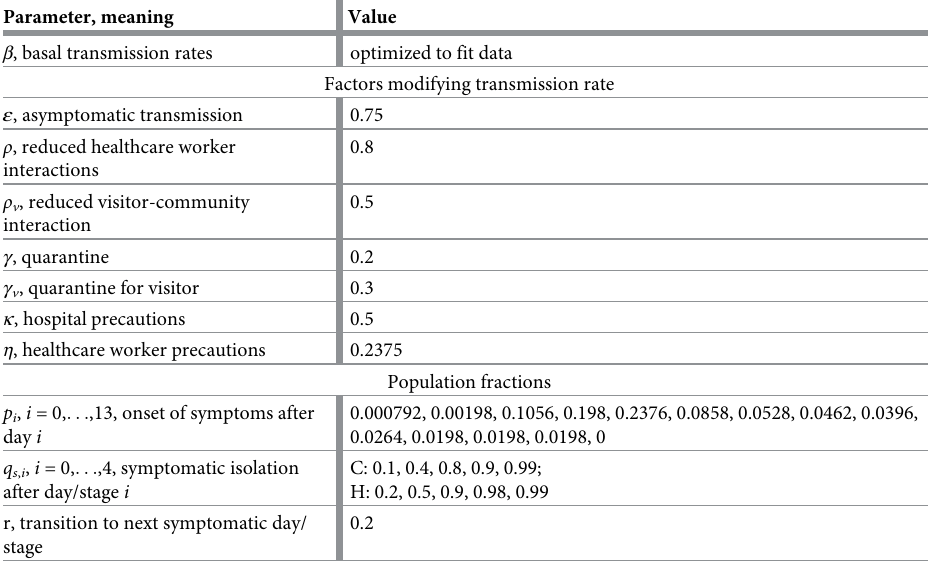
Table 1. Variable and parameters common for all geographic locations.